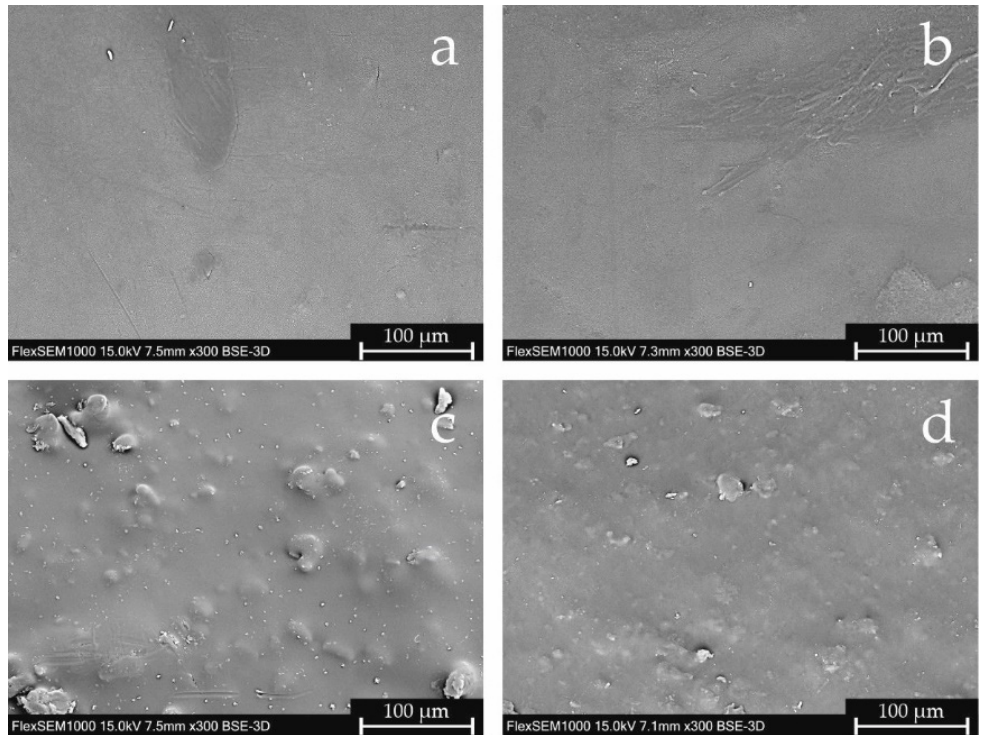
Figure 1. SEM pictures of filaments’ surfaces: ( a )—PAR, ( b )—PAR + M, ( c )—DOM, ( d )—DOM + M (magnification 300×).